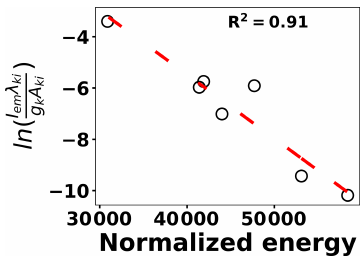
Figure 7. Boltzmann plot for various Tungsten lines in order to es- timate plasma